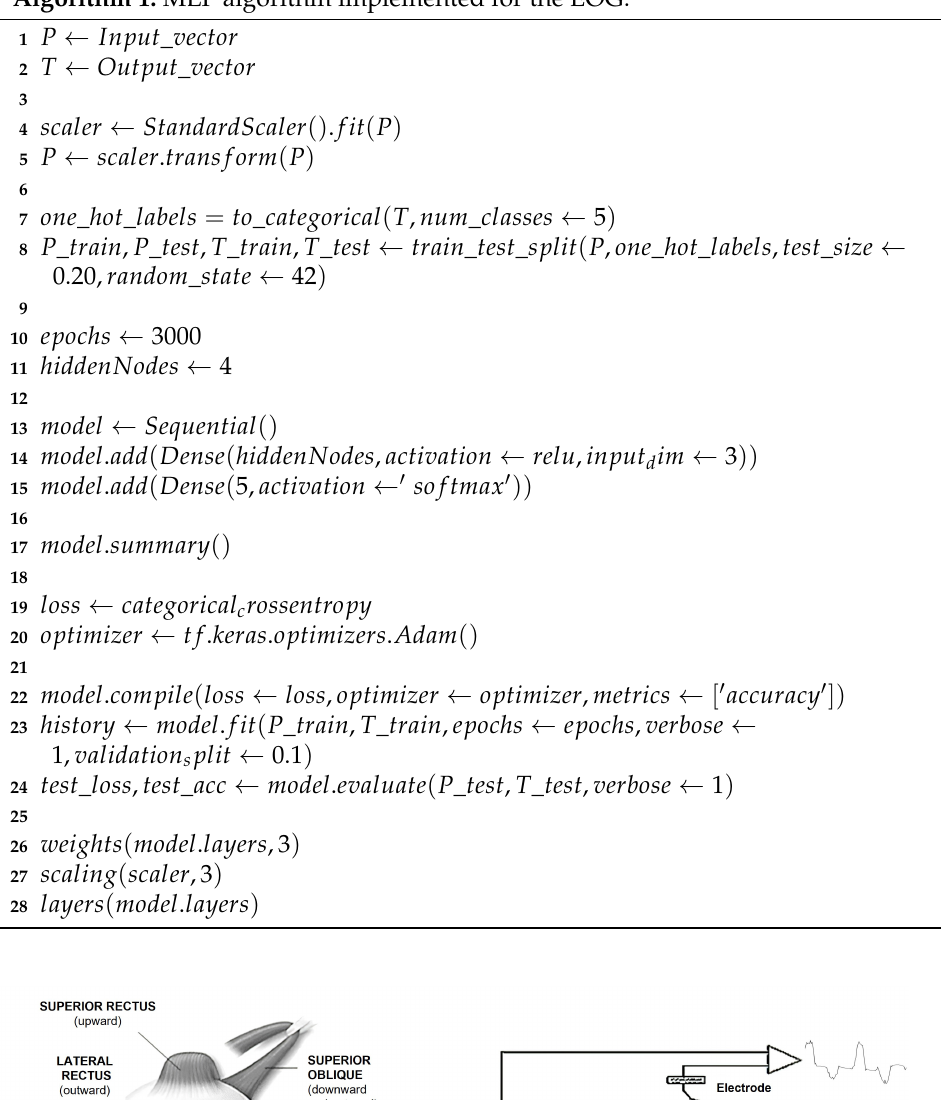
Algorithm 1: MLP algorithm implemented for the EOG.